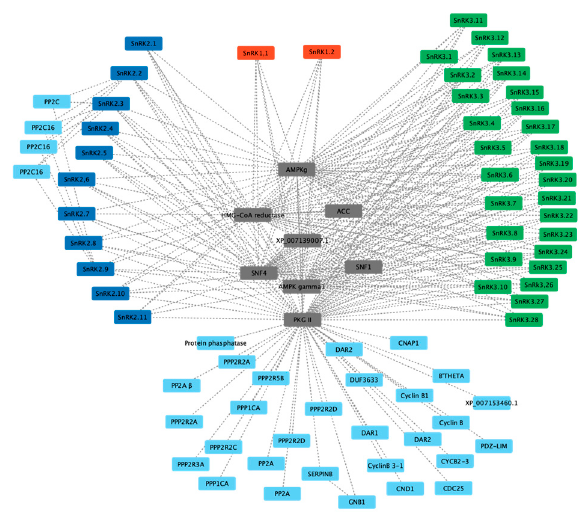
Figure 7. In silico prediction of protein–protein interactions among SnRK1s , SnRK2s and SnRK3s using the Cytoscape tool based on the Pearson correlation coefficients of the relative expression of the gene. Each node represents a protein, and each edge refers an interaction. The red-coloured box represents SnRK1s , blue represents SnRK2s, and green represents SnRK3s .